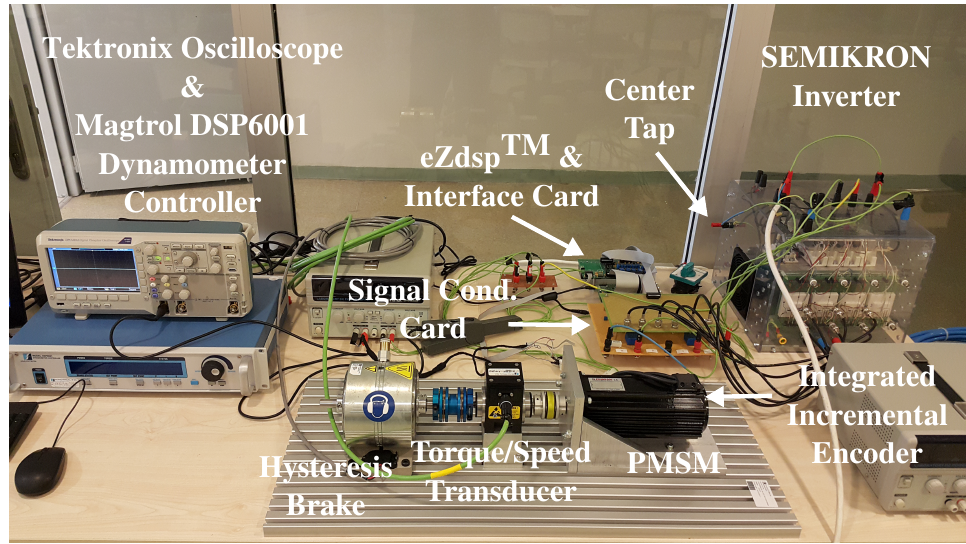
Figure 5. A 1 kW experimental